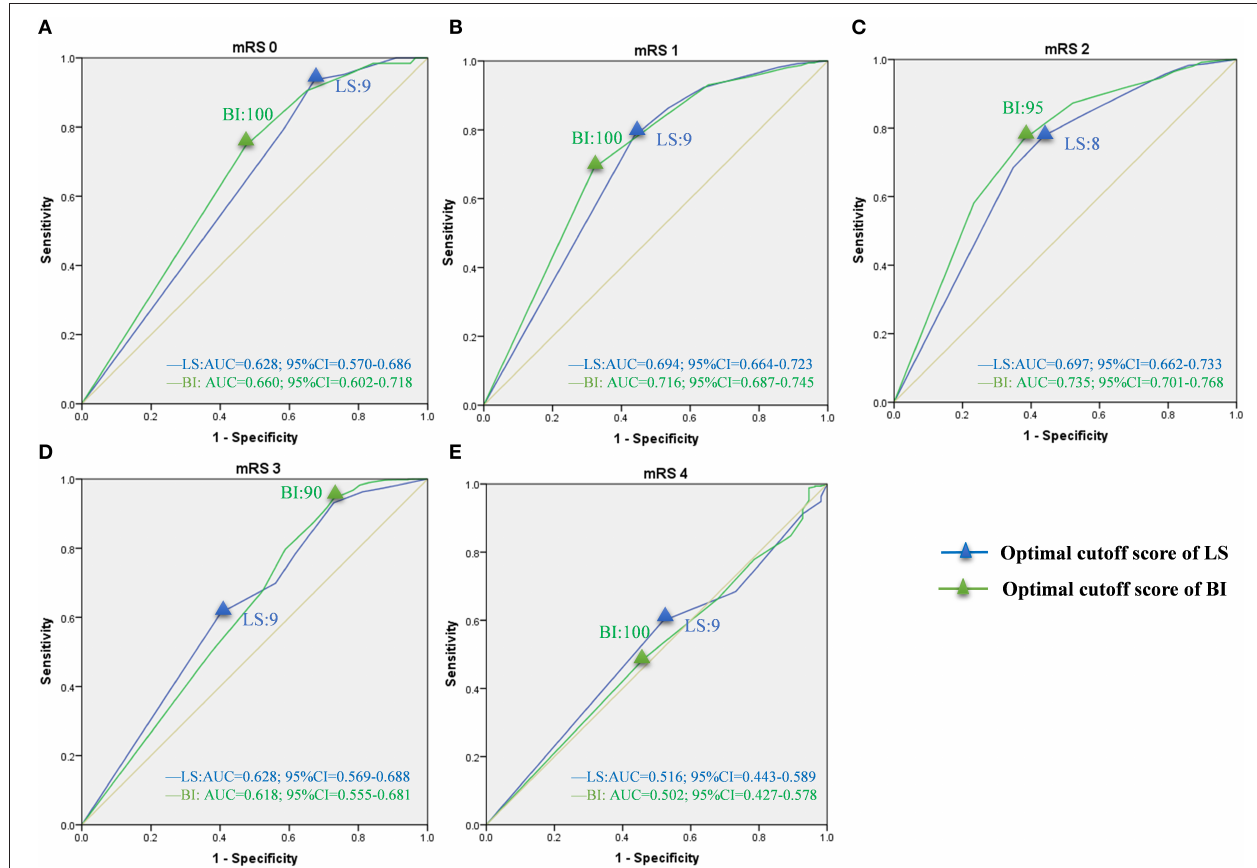
FIGURE 5 | ROC curves of LS and BI cutoff scores corresponding to mRS grades in the community group. LS, Longshi Scale; BI, Barthel Index Scale; mRS, modified Rankin Scale; ROC, Receiver Operating Characteristic; AUC, Area Under Curve; CI, Confidence Interval. (A) ROC curves for LS and BI cutoff scores in mRS 0. Optimal cutoff score: 9 and 100; Sensitivity: 93.7 and 74.6%; specificity: 32.7 and 52.6%; AUC: 0.628 and 0.660, respectively. (B) ROC curves for LS and BI cutoff scores in mRS 1. Optimal cutoff score: 9 and 100; Sensitivity: 78.2 and 68.9%; specificity: 56.2 and 68.0%; AUC: 0.694 and 0.716, respectively. (C) ROC curves for LS and BI cutoff scores in mRS 2. Optimal cutoff score: 8 and 95; Sensitivity: 77.8 and 76.7%; specificity: 43.8 and 62.1%; AUC: 0.697 and 0.735, respectively. (D) ROC curves for LS and BI cutoff scores in mRS 3. Optimal cutoff score: 9 and 75; Sensitivity: 61.3 and 94.4%; specificity: 59.8 and 27.1%; AUC: 0.628 and 0.618, respectively. (E) ROC curves for LS and BI cutoff scores in mRS 4. Optimal cutoff score: 9 and 100; Sensitivity: 59.8 and 48.9%; specificity: 48.2 and 53.6%; AUC: 0.516 and 0.502,